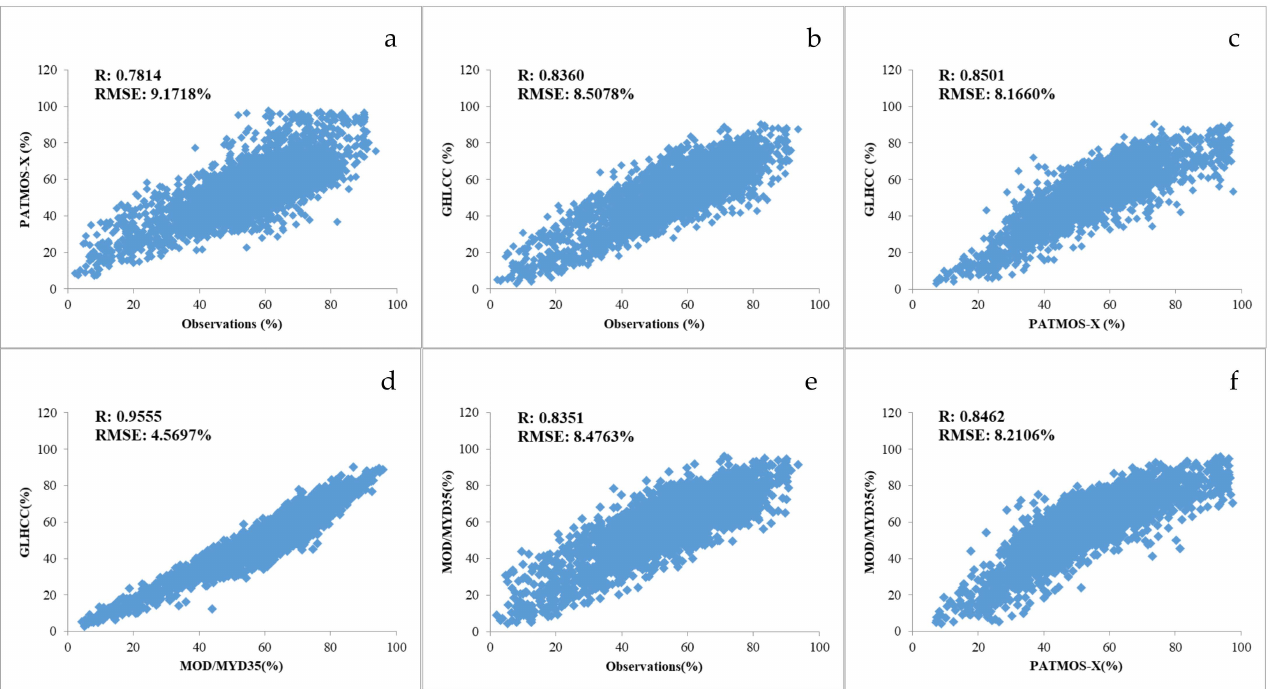
Figure 27. Correlation analysis of the PATMOS-X ( a ), GLHCC ( b – d ), MOD/MYD35 ( e , f ) and observation data in